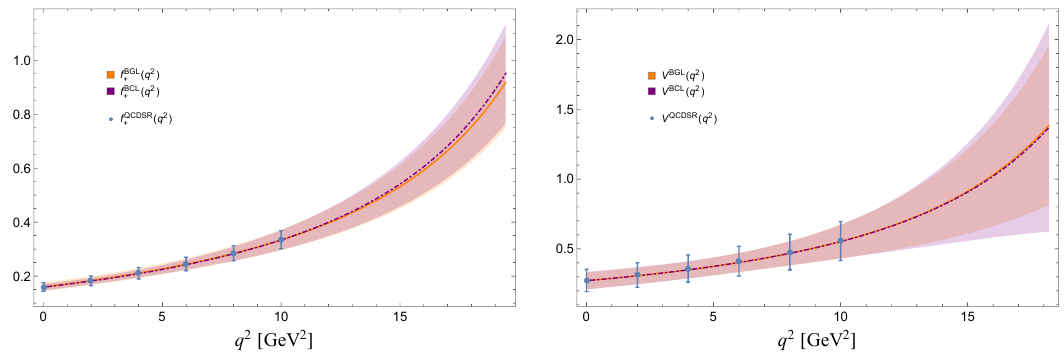
Table 4 . Summary of the (cid:12)ts for B c ! D and B c ! D (cid:3) form factors.